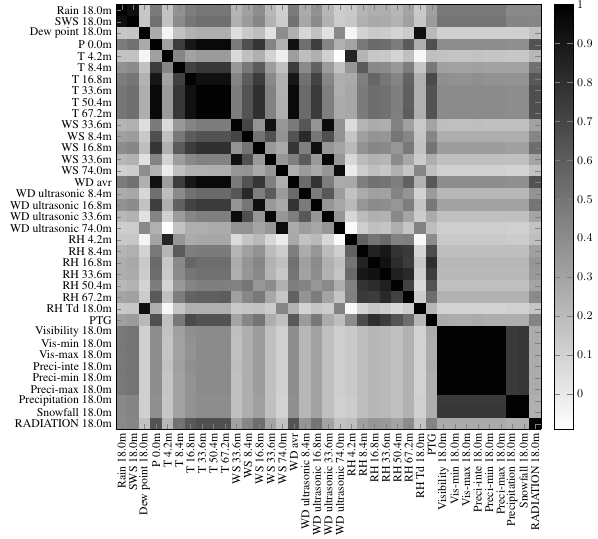
Figure 3. Correlation of missing value patterns. High correlation (indicated by darker values) means that the values are often missing together.